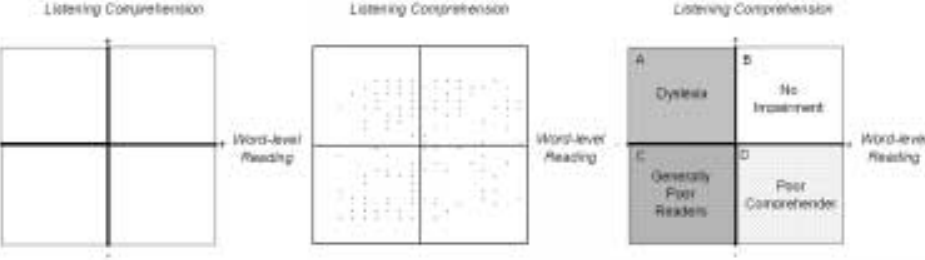
Figure 2. The simple view of